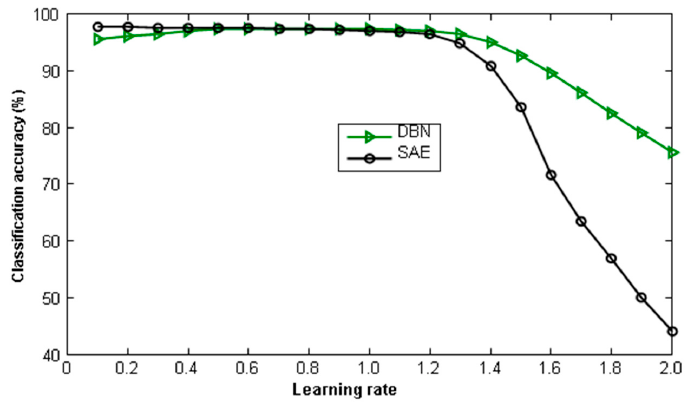
Figure 14. Classification accuracy with learning rate variation.